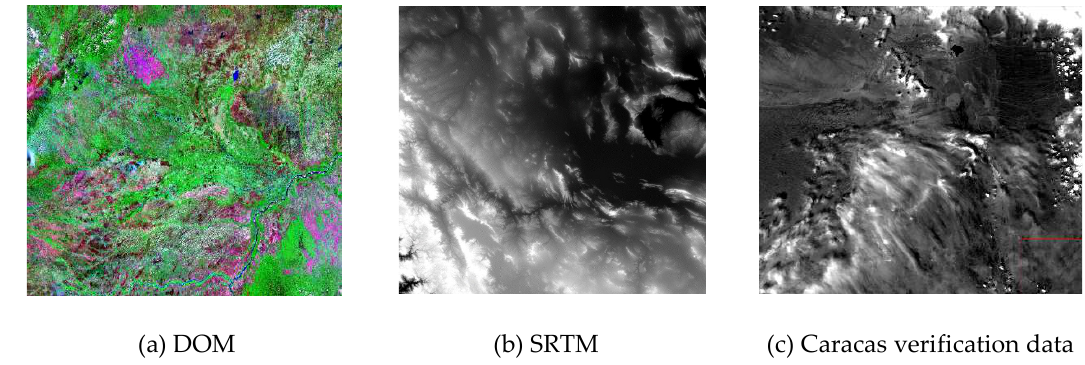
Figure 6. Caracas regional control and verification data.